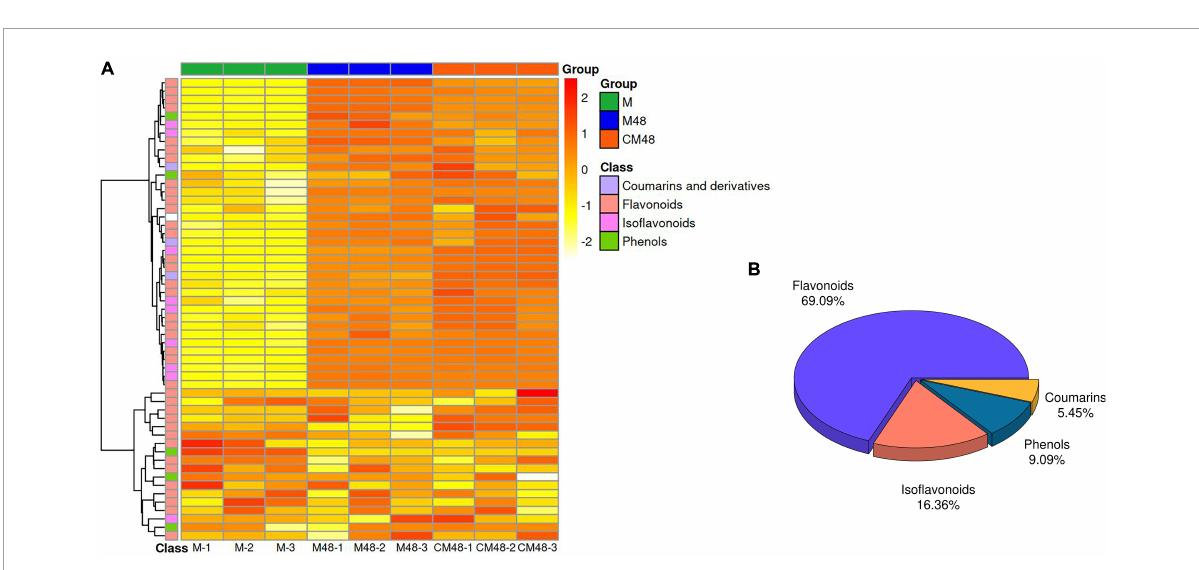
FIGURE6 Polyphenol metabolites heat map (A) and component ratio chart (B) of mung bean sprouts. M, untreated mung bean; CM48, mung bean germinated for 48 h; M48, mung bean pretreated with ultrasonic and γ -aminobutyric acid (GABA) and germinated for 48 h.